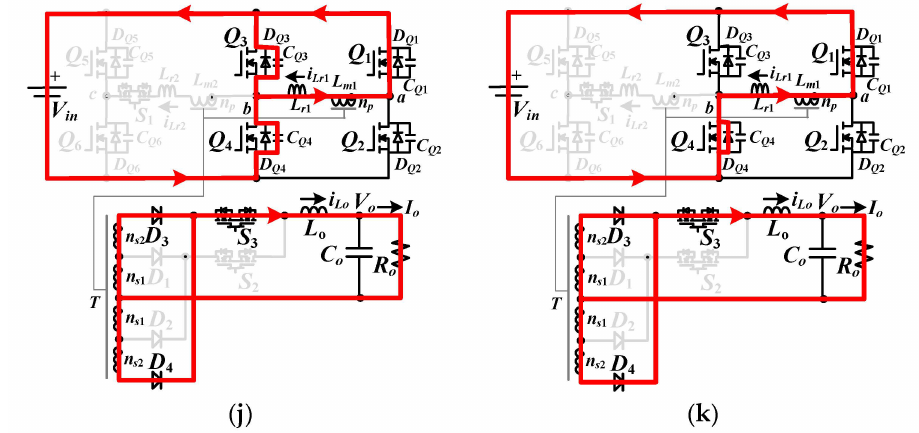
Figure 3. PWM waveforms and equivalent circuits at low voltage range operation: ( a ) PWM